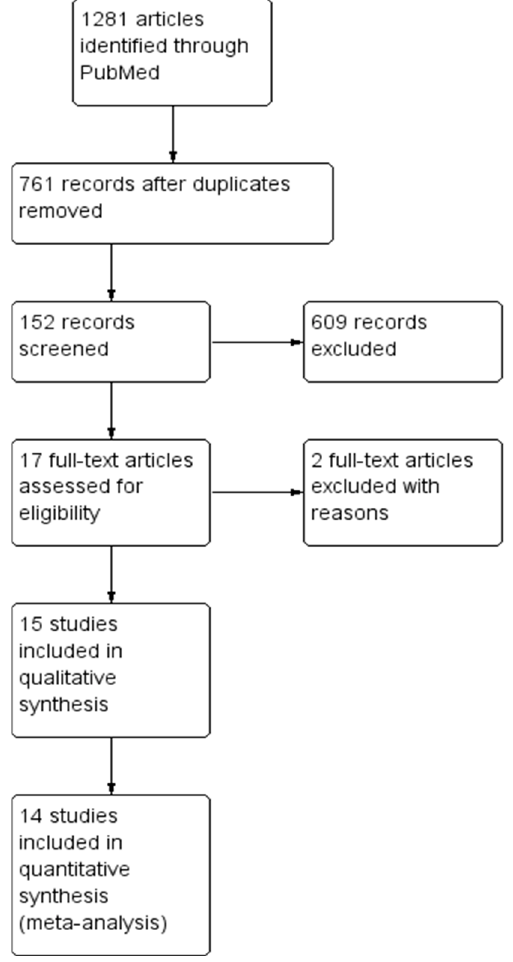
Figure 1. Study flow